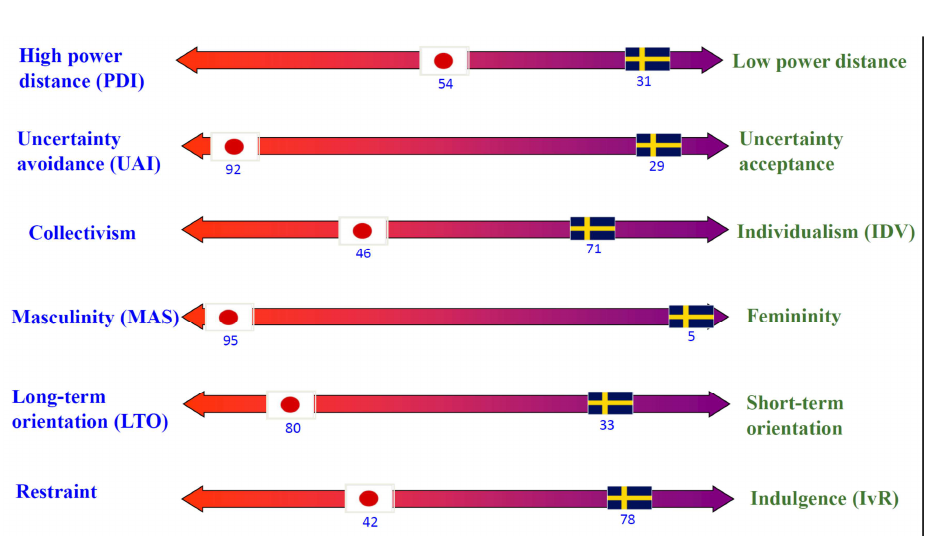
Figure 1 – Hofstede et al.'s (2010) cultural dimensions for Japan and